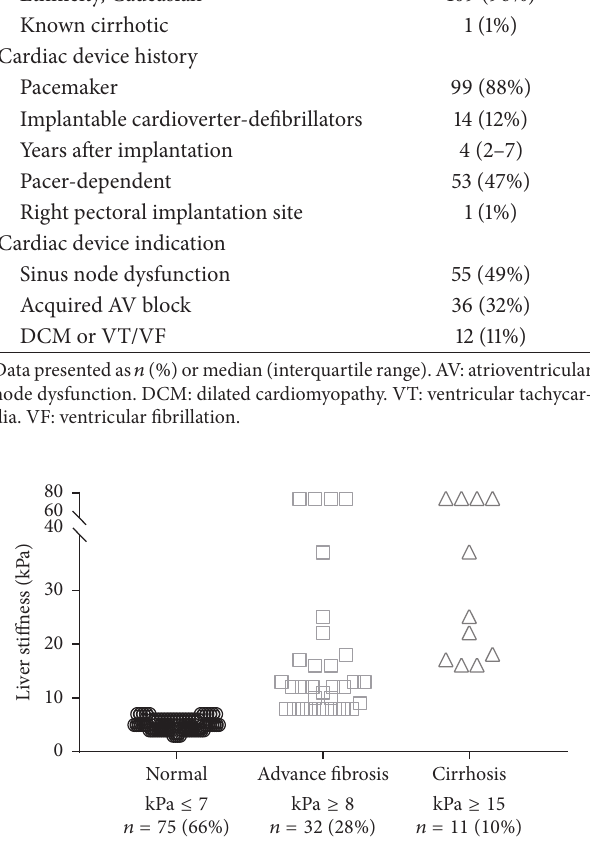
Figure1:Numberandpercentageofsubjectswithnormal,advanced fibrosis, and cirrhosis based on their liver stiffness measurement.